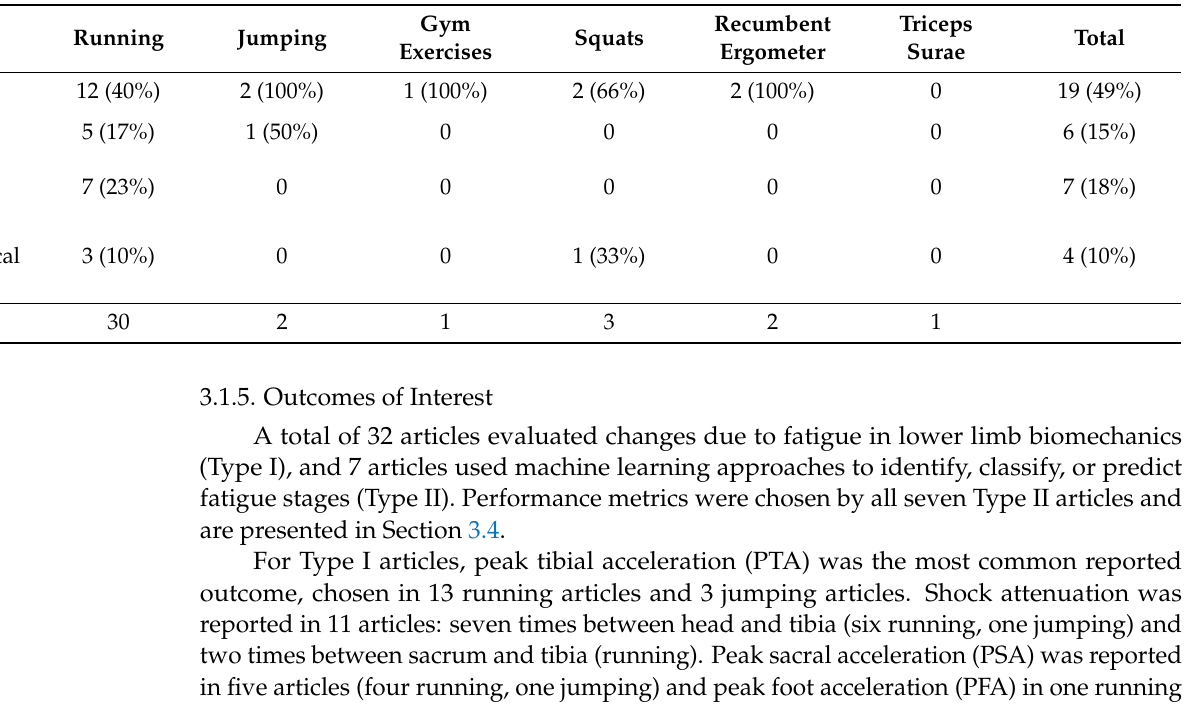
Table 5. Fatigue reference across fatiguing protocols: number of articles and